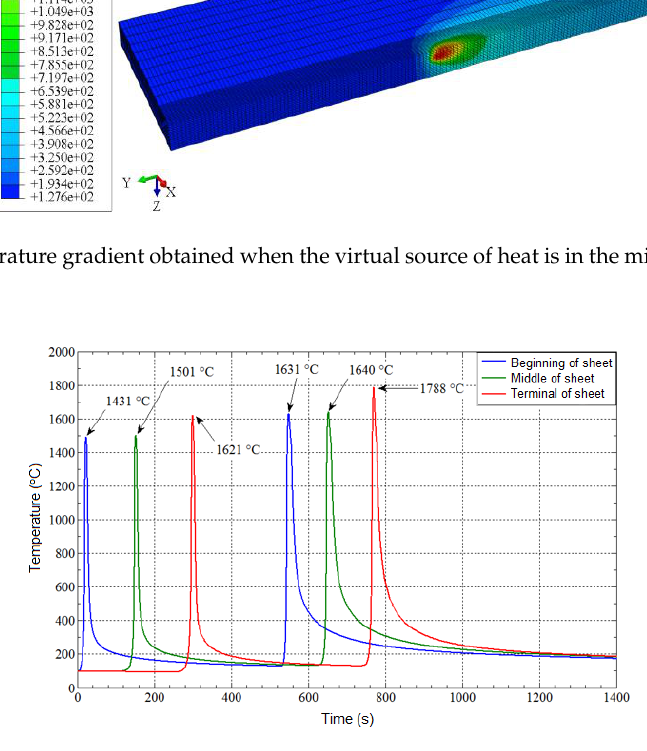
Figure 11. Temperature cycles evaluated at the beginning, middle and end of the welding process at a point located 0.002 m from the heat source.